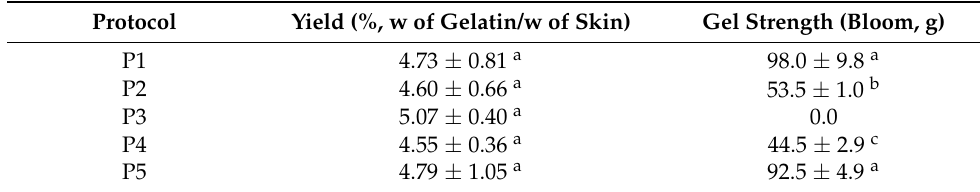
Table 3. Yield and gel strength for gelatin extracted from salmon fresh skins under the various protocols of production tested. Values are average ± intervals of confidence for n = 2 (replicates of independent batches) and α = 0.05. Different letters (a, b and c) in each file (as superscript) mean significant difference between protocols ( p < 0.05).